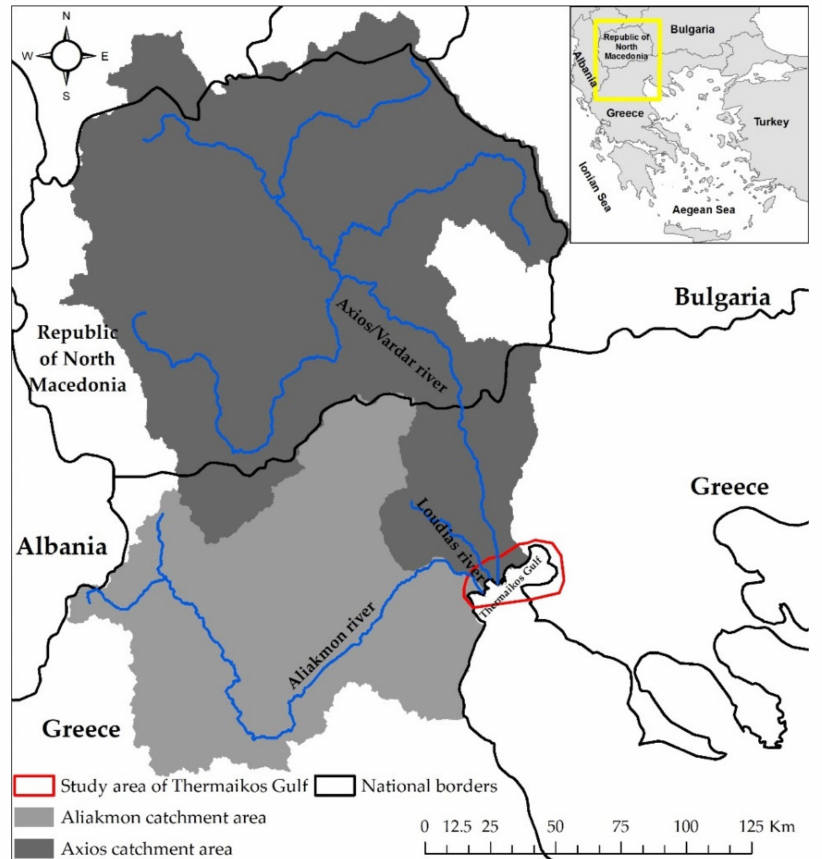
Figure 1. Study area (red polygon). The yellow polygon shows the location of the study area (main map) in and around of Greece.